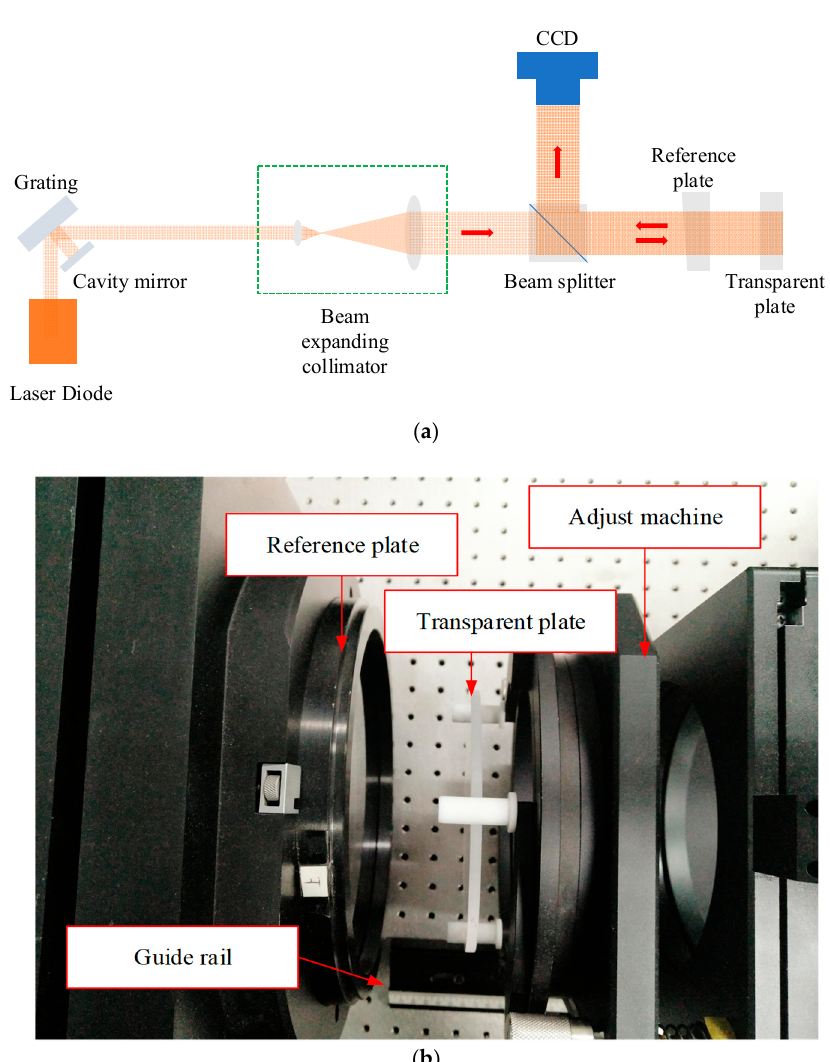
Figure 4. Experimental setup. ( a ) Schematic diagram of the interferometer used to measure the profiles of the front and rear surfaces; ( b ) laboratory photo of the measuring area of the transparent plate in a wavelength-tuning